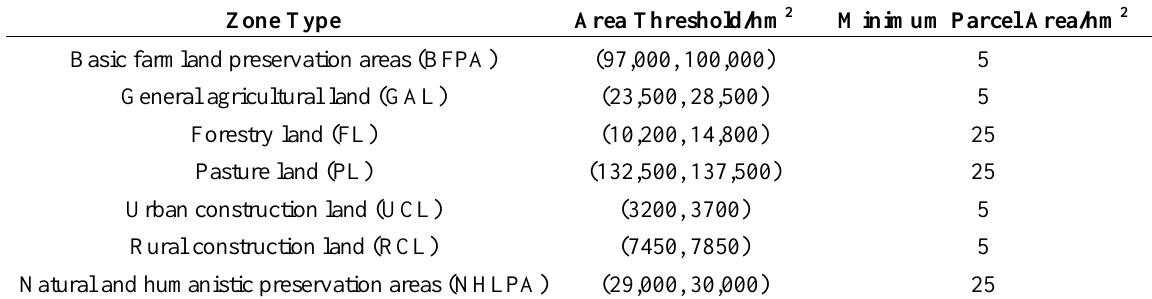
Table 1. Descriptions of land use zones in Yuzhong